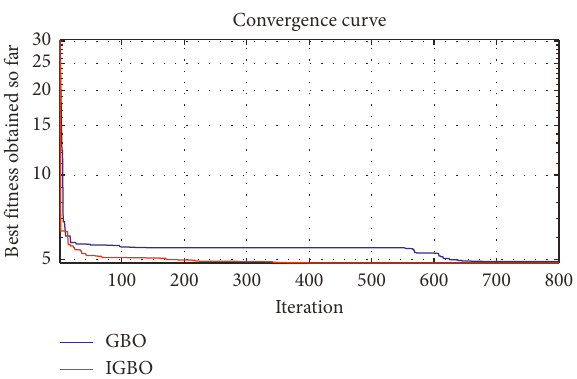
Figure 8: SAE convergence for model 3.